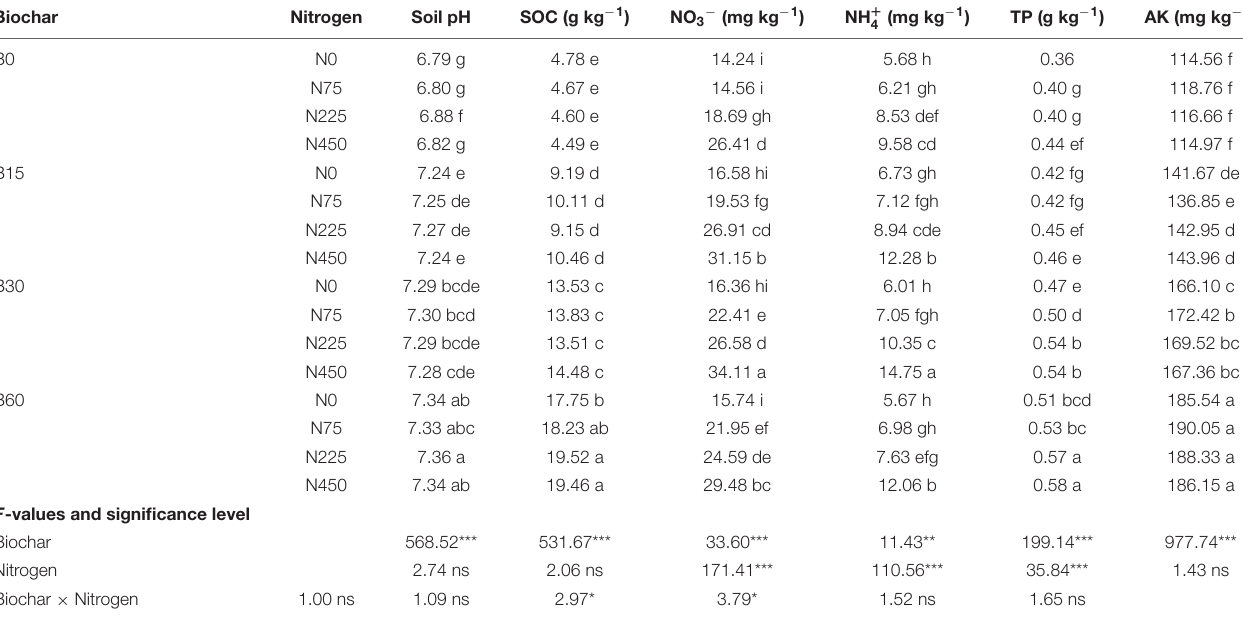
TABLE 3 | Integrated effect of biochar and nitrogen application on chemical properties of soil during 2020–2021.